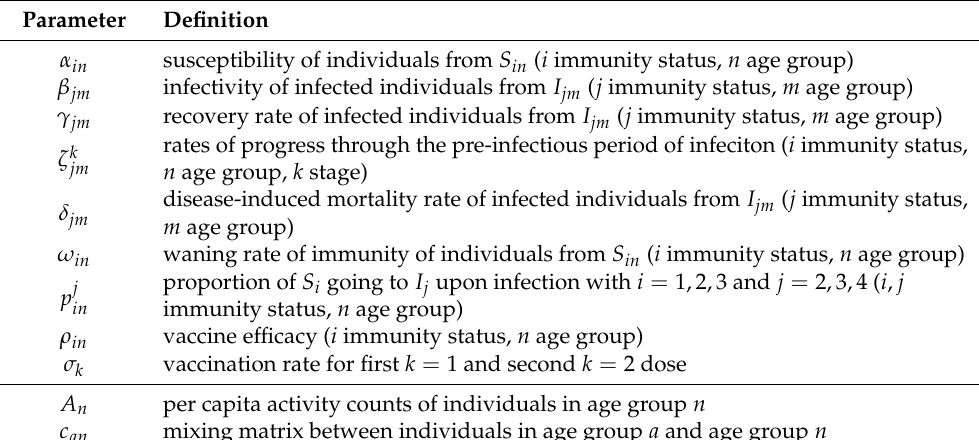
Table A1. Parameter definitions for the ODE